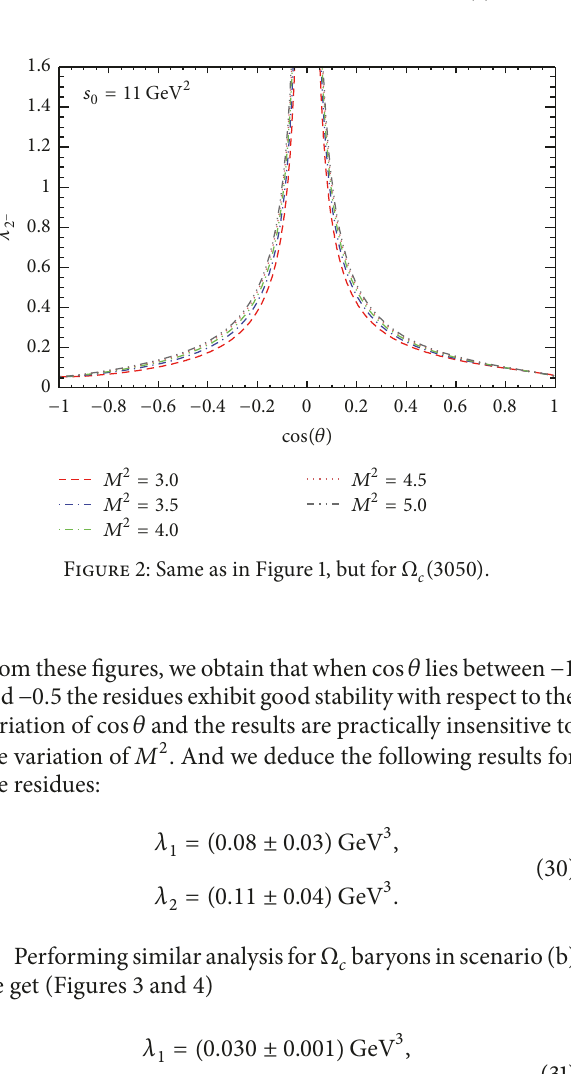
Figure 1: The dependence of residue for Ω 𝑐 (3000) on cos 𝜃 at 𝑠 0 = 11 GeV 2 and at various fixed values of 𝑀 2 for scenario (a).